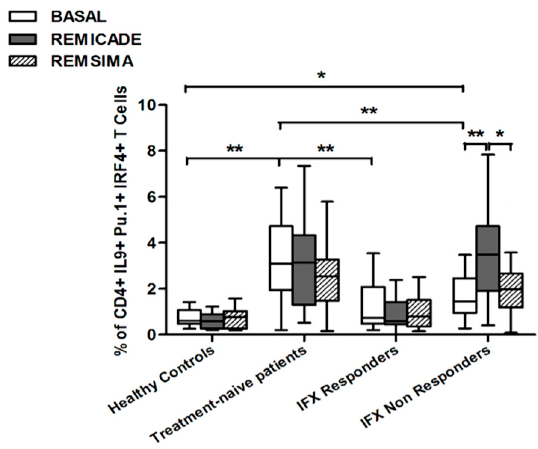
Figure 1. Percentages of PU.1 + , IRF4 + , IL-9 + CD4 + T cells at baseline and after exposure to branded and biosimilar infliximab. * p < 0.05, ** p < 0.01.